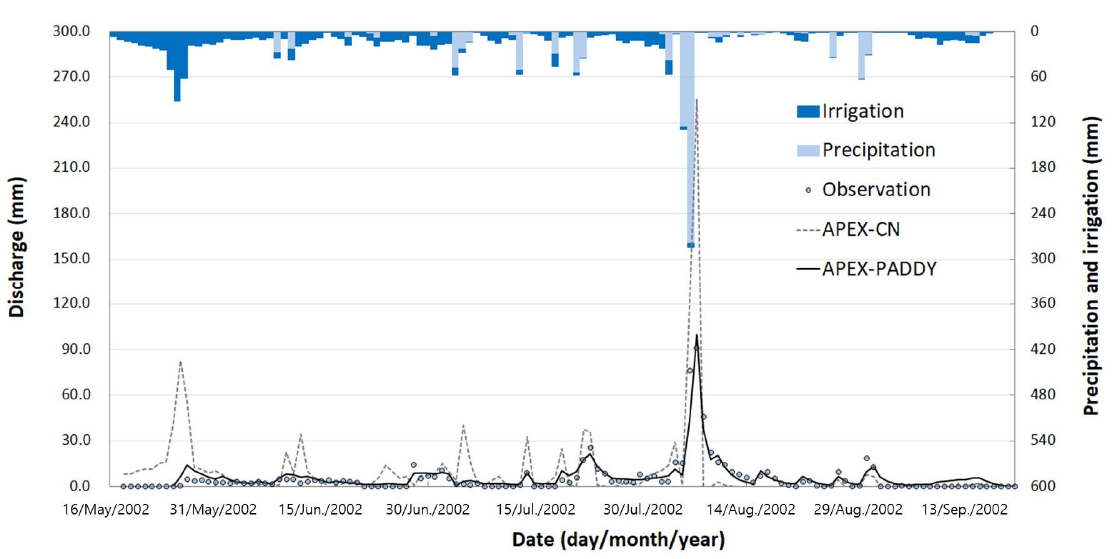
Figure 7. Predicted daily discharge hydrographs indicate that APEX ‐ Paddy successfully simulates high peaks in daily discharge at the Icheon site by allowing surface retention of stormwater. The APEX1501 model with the SCS ‐ CN method over ‐ predicted peak daily discharges up to 250% of the measured value.